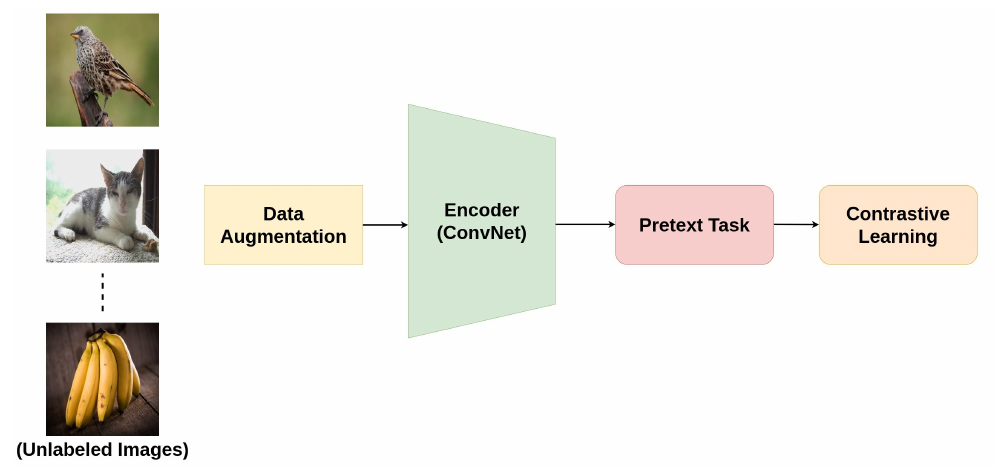
Figure 2. Contrastive learning pipeline for self-supervised training.